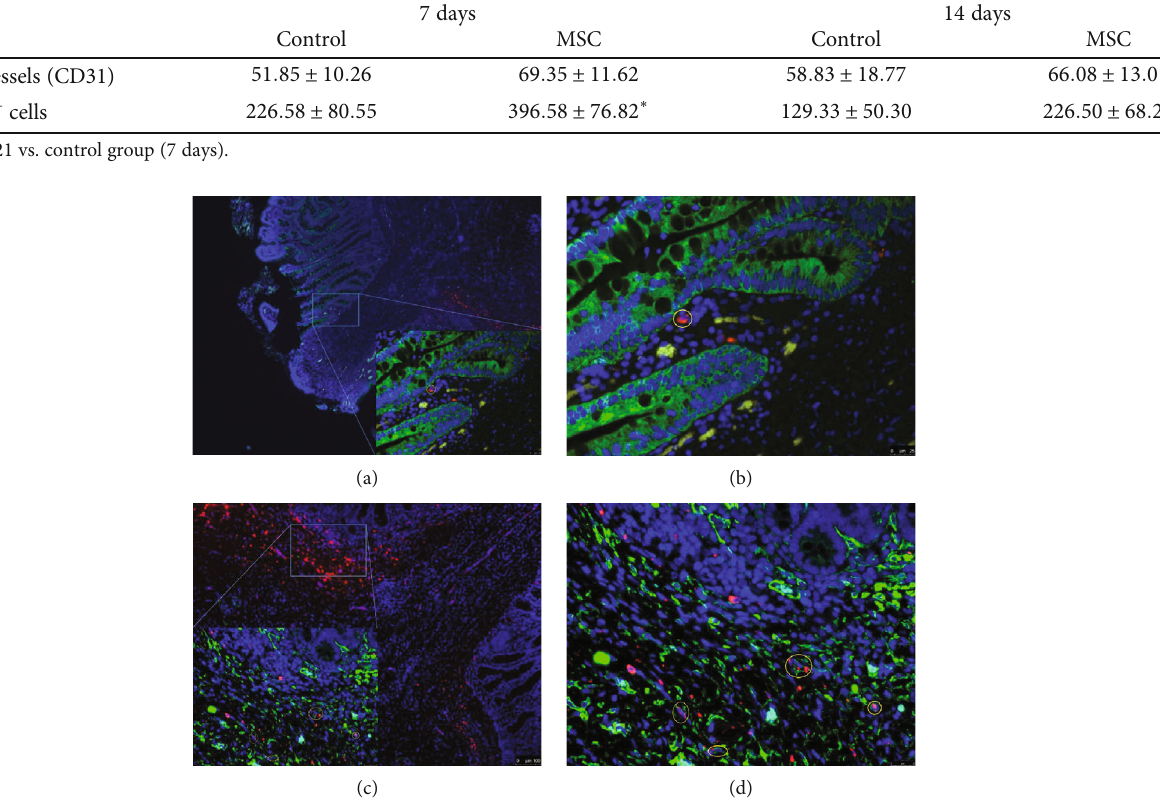
Figure 3: MSC tracking and di ff erentiation. (a) Tracking of grafted MSCs (50x) on d 14. (b) Tracking of grafted MSCs (400x) on d 14, showing a zoomed-in view of (a). (c) Di ff erentiation of smooth muscle cells from grafted MSCs (50x) on d 14. (d) Di ff erentiation of smooth muscle cells from grafted MSCs (400x) on d 14, showing a zoomed-in view of (c). Red: CM-Dil fl uorescent dye. Green: anti-alpha smooth muscle actin in (a, b) and pan cytokeratin in (c, d). Blue: 4,6-diamidino-2-phenylindole. Table 3: Western blot analysis of three proteins involved in the wound healing process ( mean ± SD